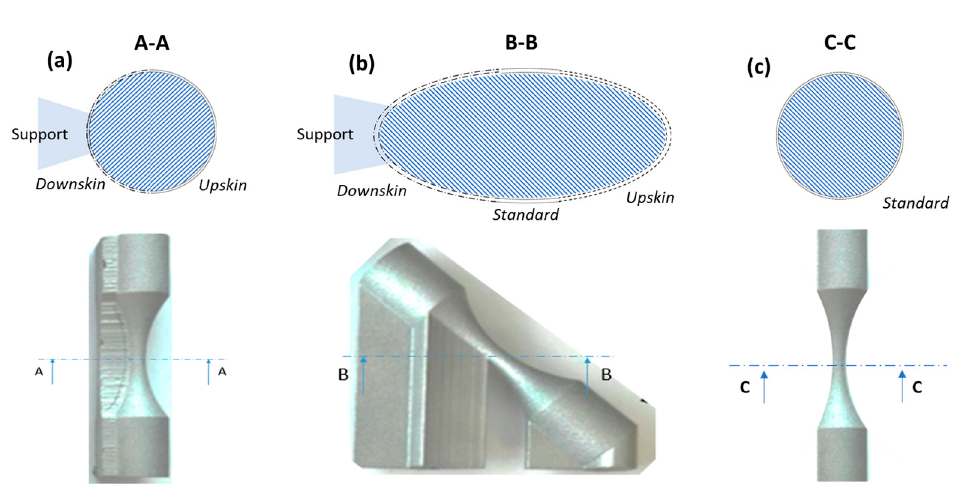
Figure 2. ( a ) Raw sample extracted from the platform, ( b ) fatigue sample after support removal and before thread machin- ing.